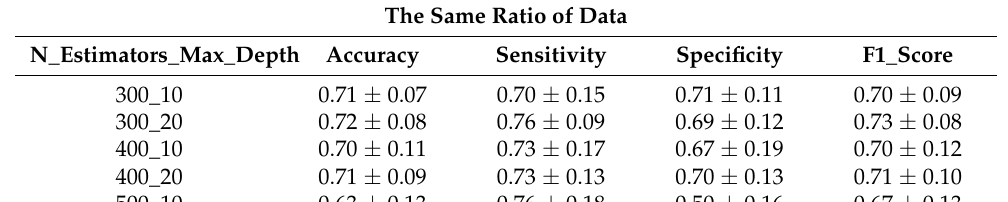
Table 4. Performance of under-sampling data.